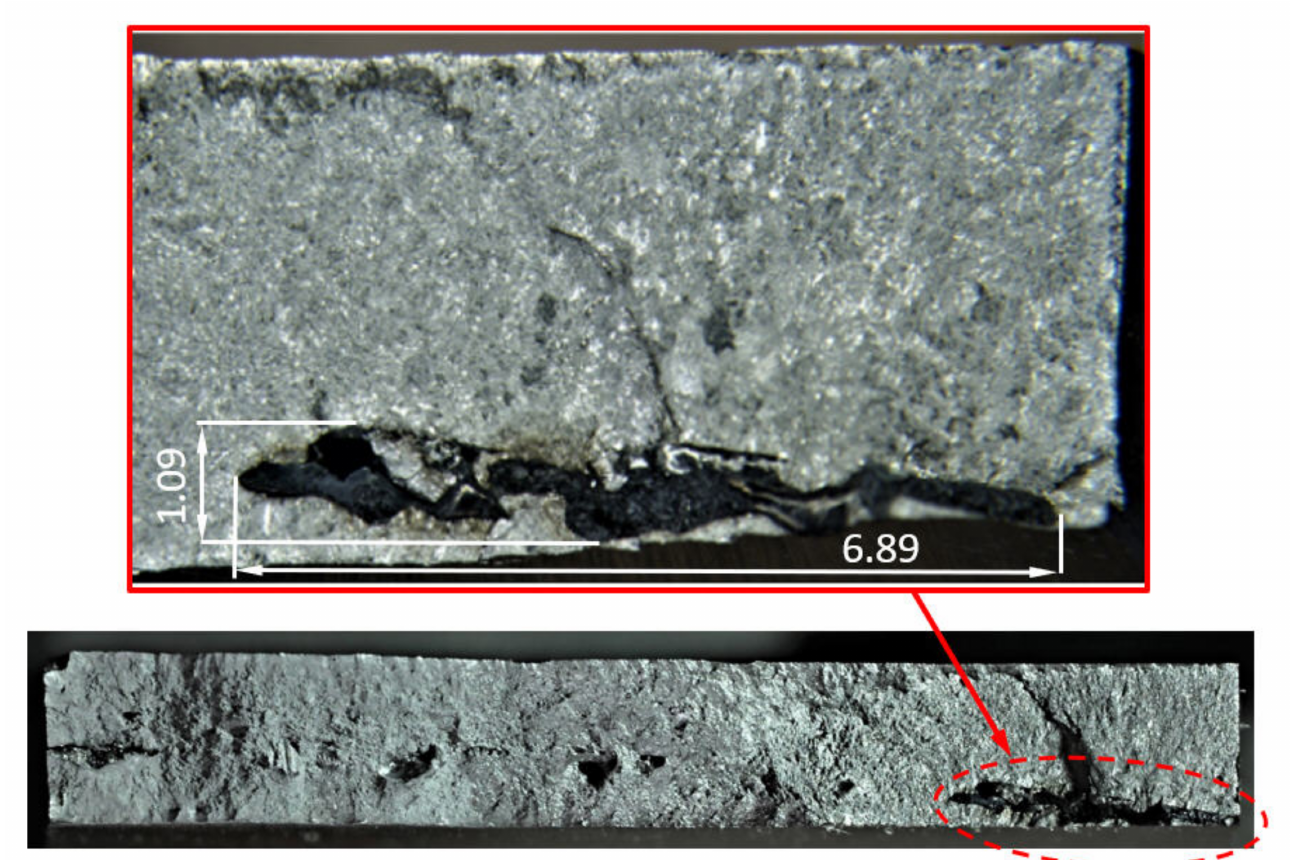
Figure 12. Cracks initiated at the edges of the internal